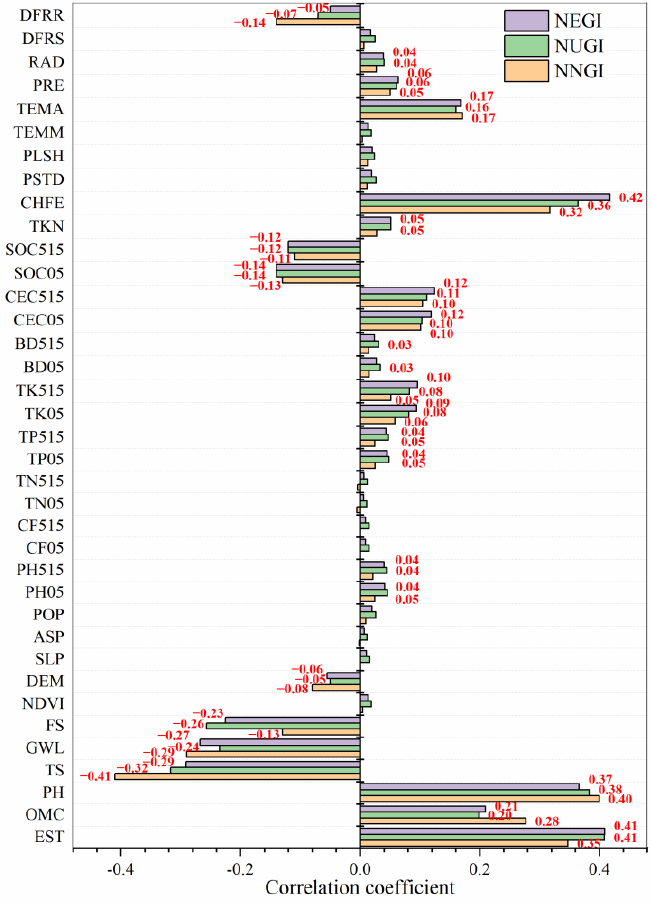
Figure 3. Correlation coefficient between 37 indicators and three different CLQ grade indices (NNGI, NUGI, and NEGI).